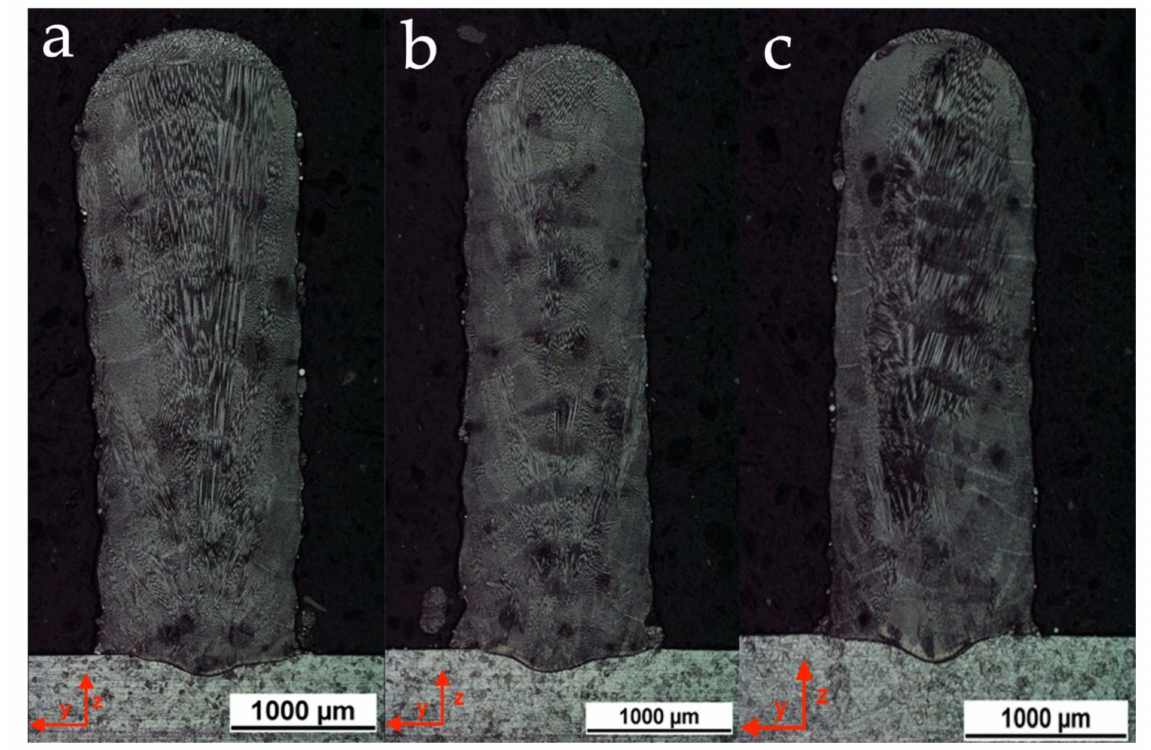
Figure 9. Macrographic cross section of the thin wall obtained using ( a ) strategy S1, ( b ) strategy S2, and ( c ) strategy